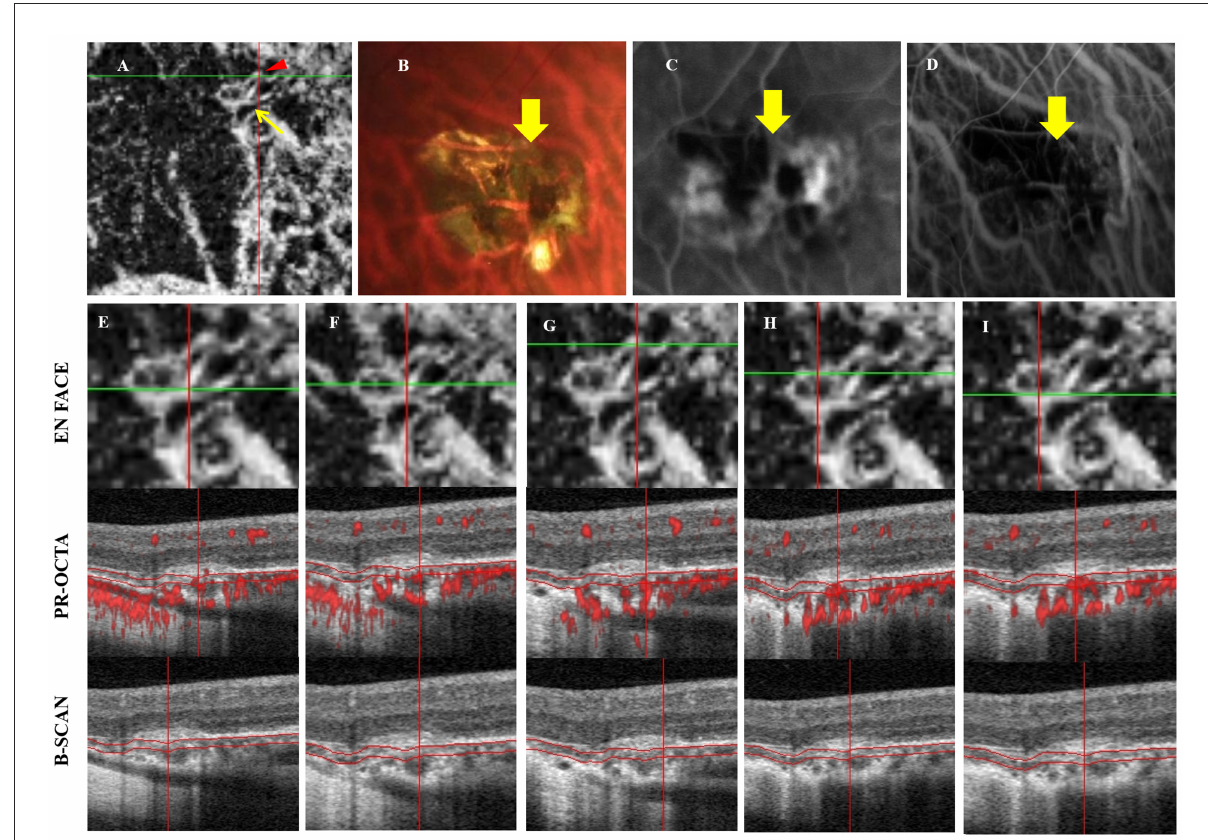
FIGURE2 Multimodal images of PSV adjacent to mCNV. A 39-year-old man complained of vision loss in his right eye for 3 weeks, his refractive error was − 16.50 D (A) OCTA indicated mCNV, yellow arrow indicated a ring-shaped CNV, where a possible feeder vessel is identified (red arrowhead). (B) Fundus photography showed an atrophic mCNV and hemorrhage, yellow arrow indicated the PSV corresponding to (A) ; (C,D) The leakage of FFA and high fluorescence of ICGA corresponding to (A) . (E – I) The OCTA after using shadow removal in each scanning position. (E,F) Indicated the scanning positions of PSV adjacent to CNV, a hyporeflective linear region was detected below CNV, Bruch’s membrane was defective in (F) , neovascularization signal was detected through PSVs and extended to the choroidal and Bruch’s membrane. The low, reflective structure